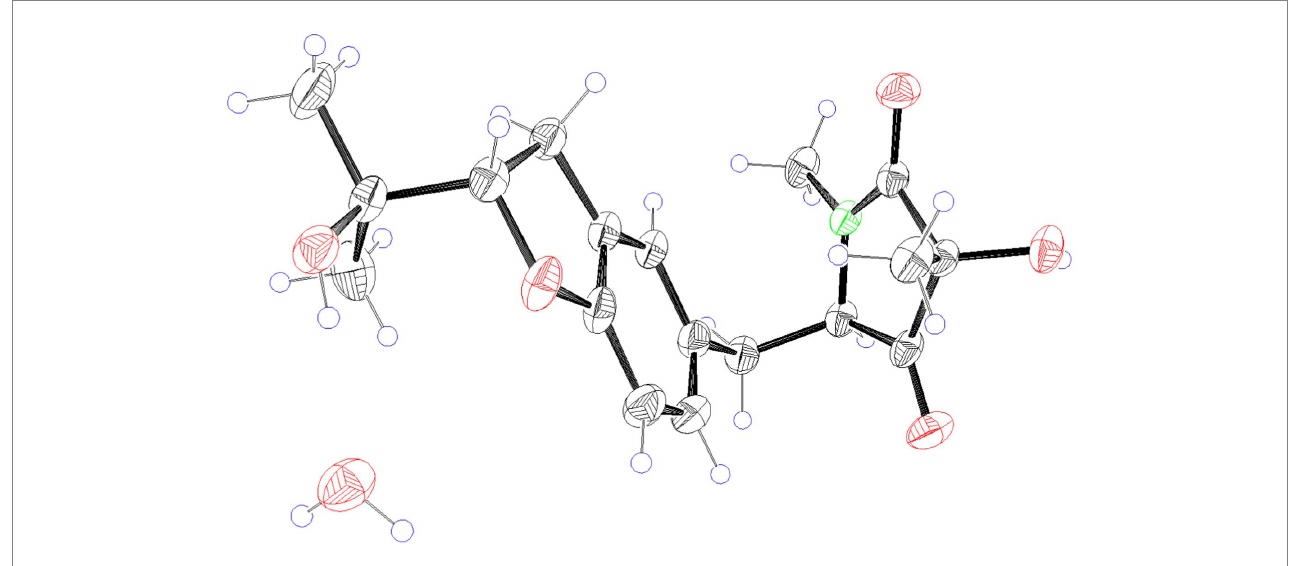
FIGURE 4 X-ray ORTEP drawing of compound 9